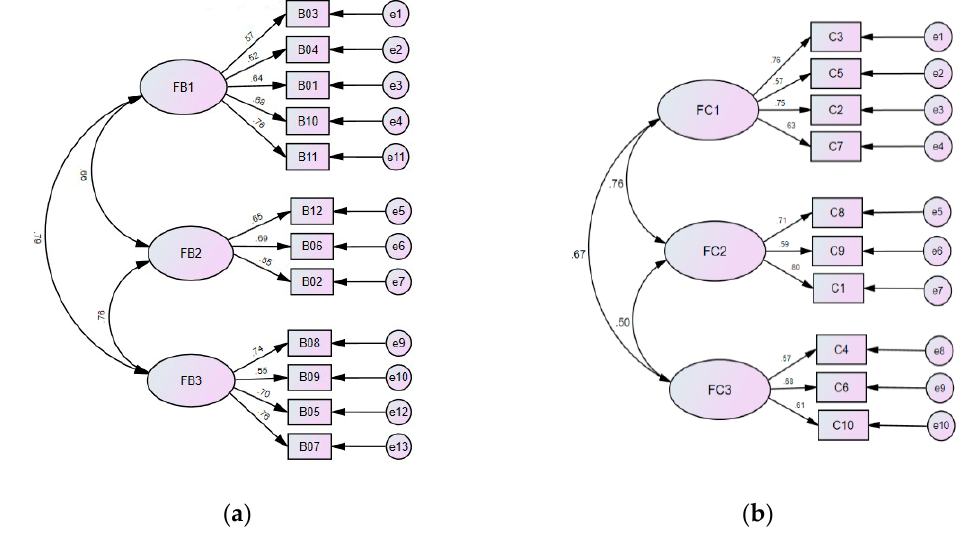
Figure 10. The 3-scale structure model graphs yielded by the CFA of the two indicators of “system usability” and “writer’s experience.” ( a ) Graph of the indicator of “system usability” (FB1: ease to learn; FB2: efficiency; FB3: satisfaction). ( b ) Graph of the indicator of “writer’s experience” (FC1: affective or cognitive experience; FC2: sensory experience; FC3: social-identity experience or behavior). Table 16. Structure-model fit indices of the two indicators of “system usability” and “writer’s experience” yielded by the CFA process a .